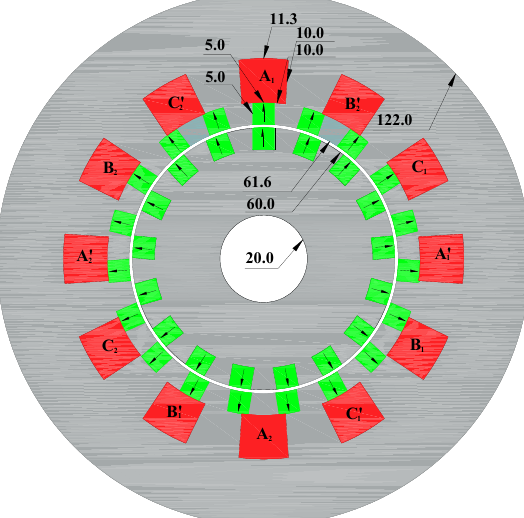
Figure 1. Geometry of the equivalent dual-permanent-magnet-excited machines (DPMM) model (mm).